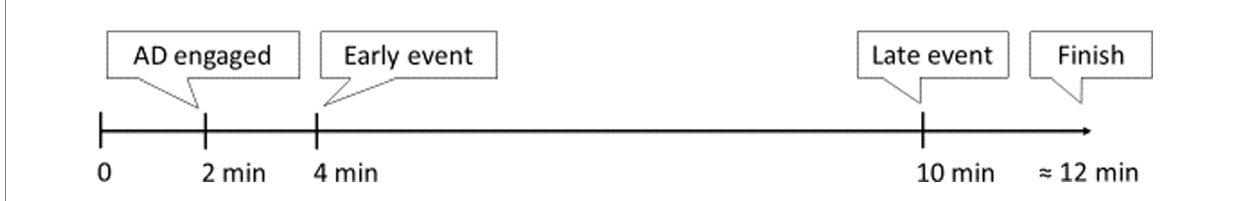
FIGURE 3 Timeline of the scenario (AD: Automated Driving).